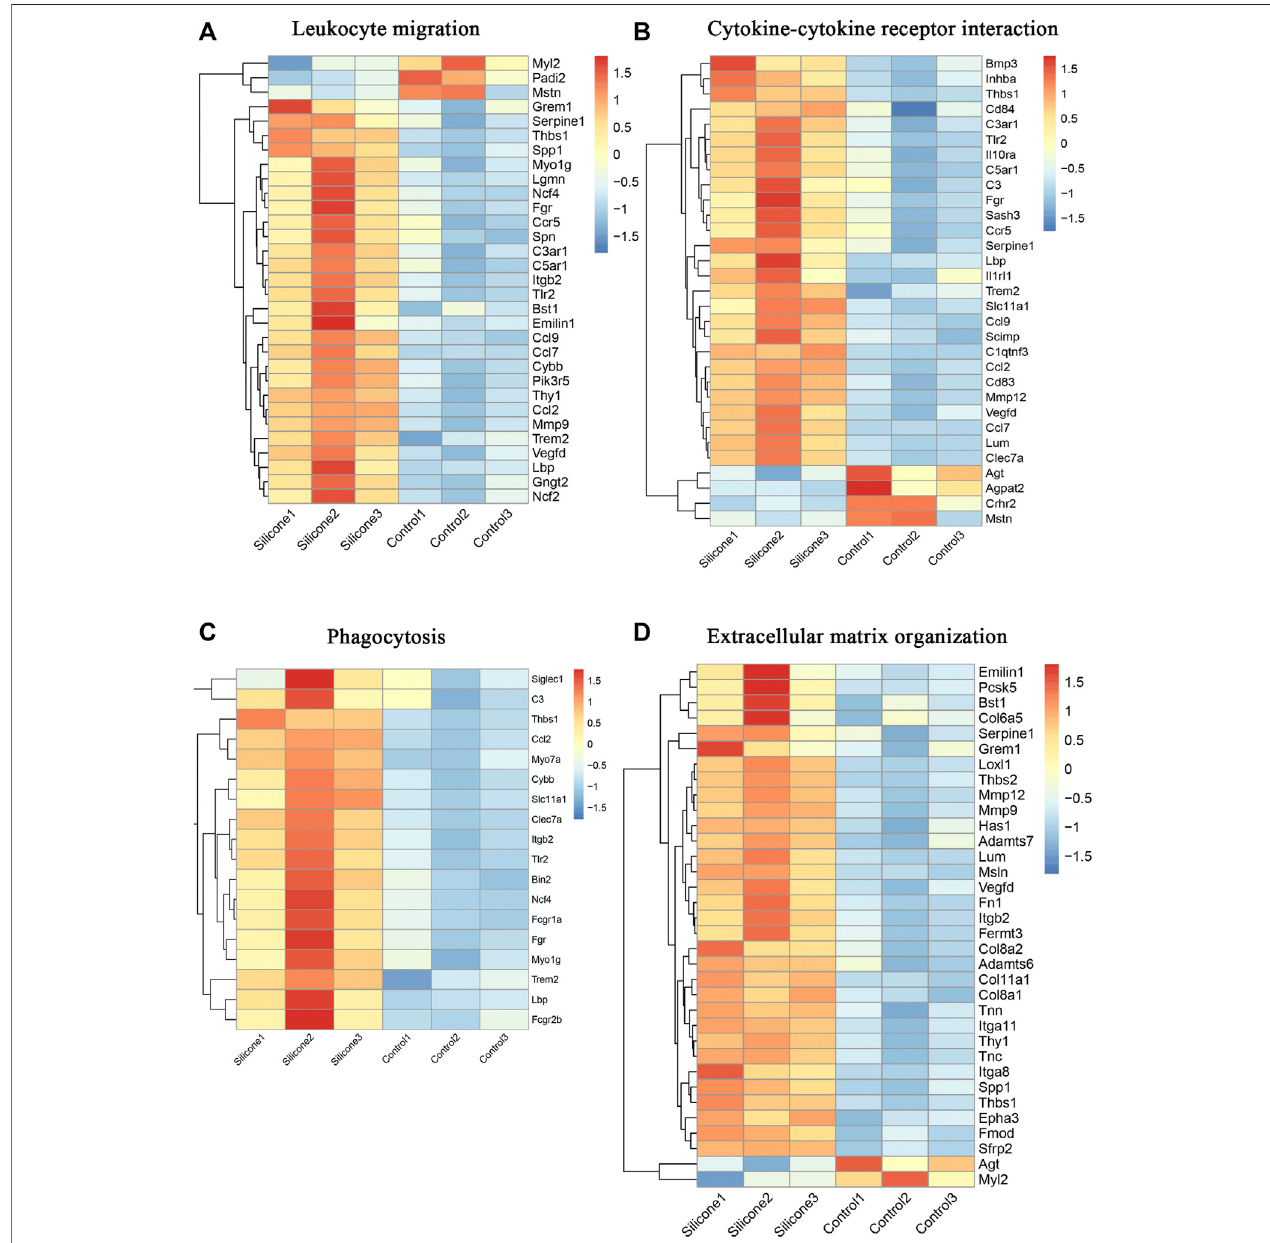
FIGURE 8 | Molecular signatures in several important biological processes in the FBR induced by silicone implantation. (A) HeatMap of molecules involved in leukocyte migration. (B) HeatMap of molecules involved in cytokine-cytokine receptor interaction. (C) HeatMap of molecules involved in phagocytosis. (D) HeatMap of molecules involved in extracellular matrix